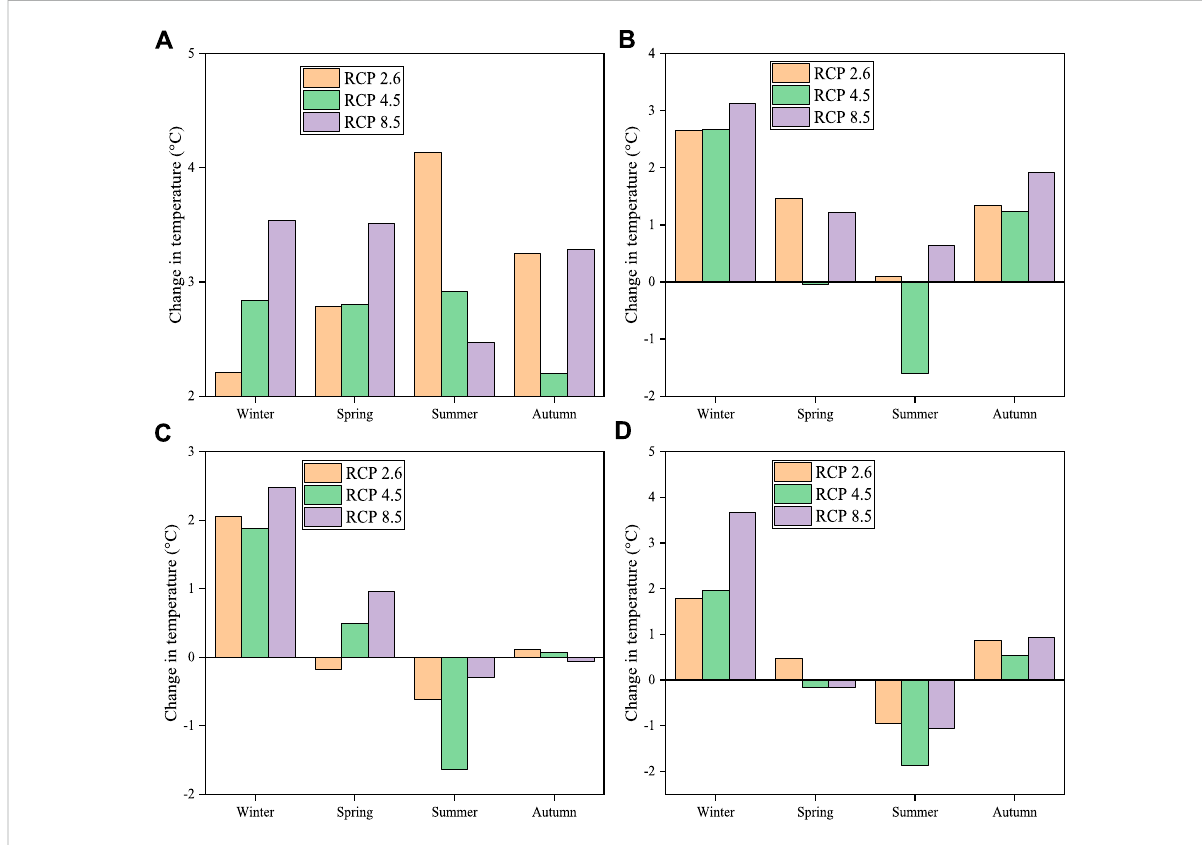
FIGURE 7 Changes in maximum seasonal temperatures of Dir (A) , Kalam (B) , Malam Jabba (C), and Saidu Sharif (D)